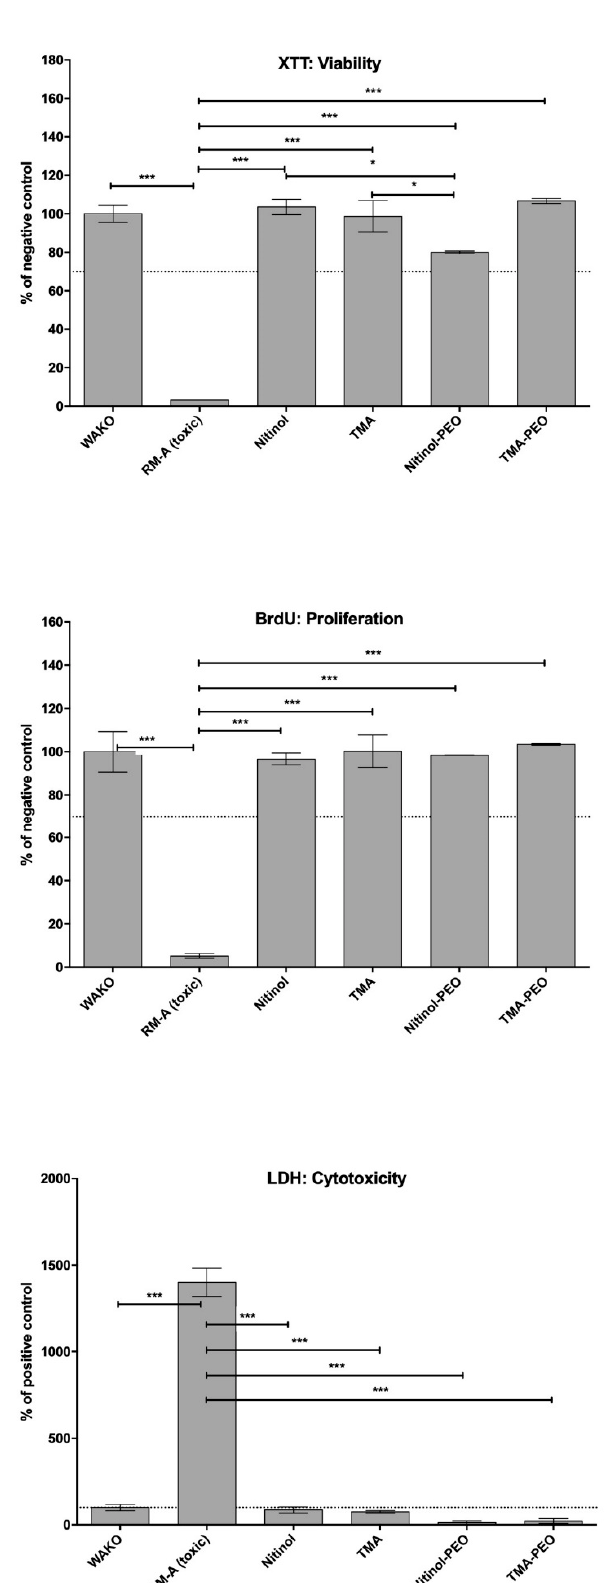
Figure 2. Cytocompatibility extract results achieved by XTT, BrdU and LDH assays. Statistical significant differences are as follows: * p ≤ 0.05 (significant different), ** p ≤ 0.01 or *** p ≤ 0.001 (high significant difference).